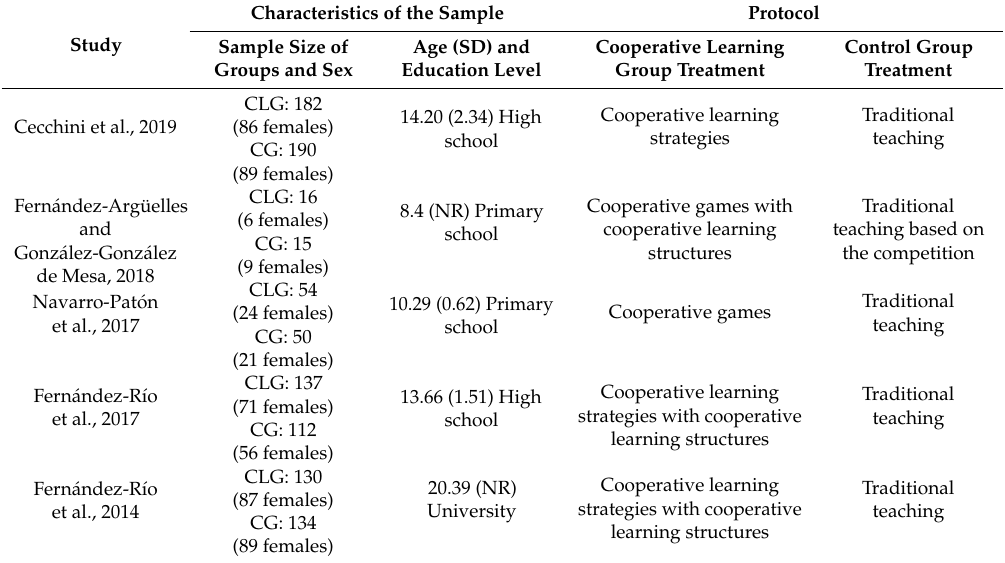
Table 2. Characteristics of the participants and the protocol.